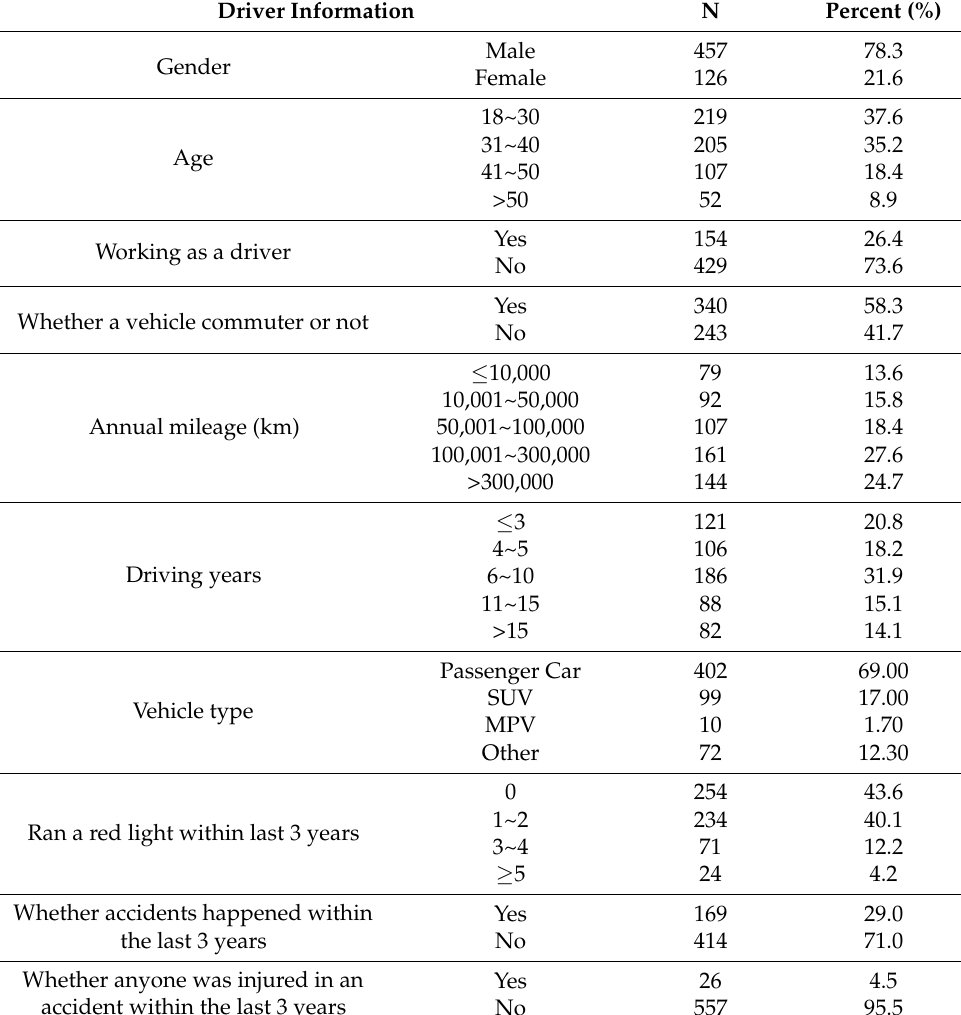
Table 1. Participant demographics ( n